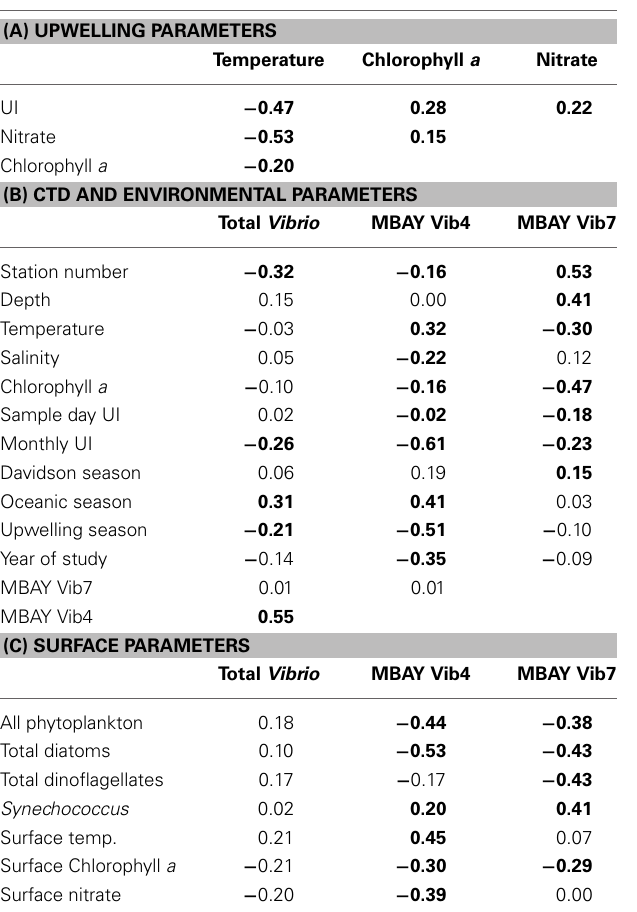
Table 3 | Spearman’s rho ( ρ s ) statistical analysis of physical and biological parameters.